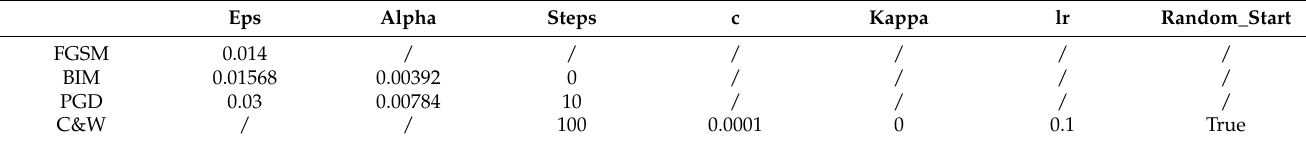
Table 2. Generating parameters for adversarial examples using